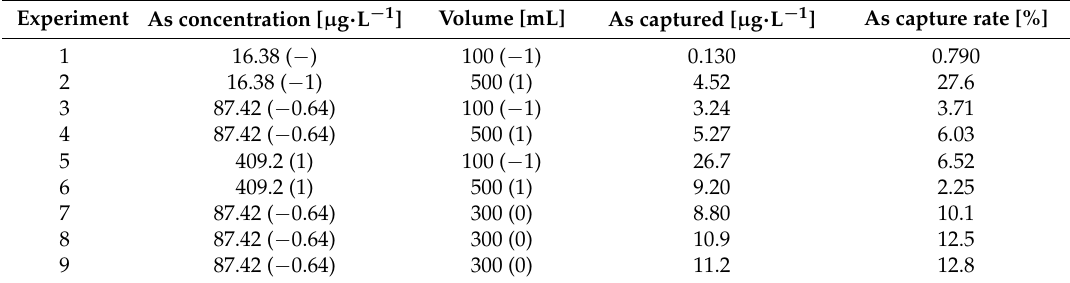
Table 1. Experiments for affinity by As performed using fill from commercial water filters.